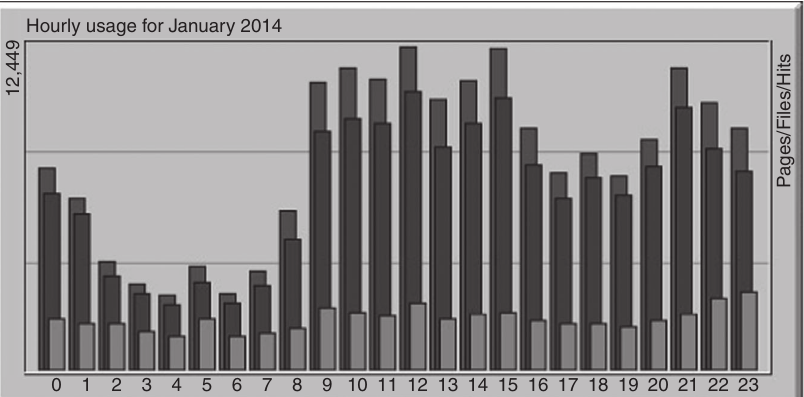
Figure 5. Hourly usage